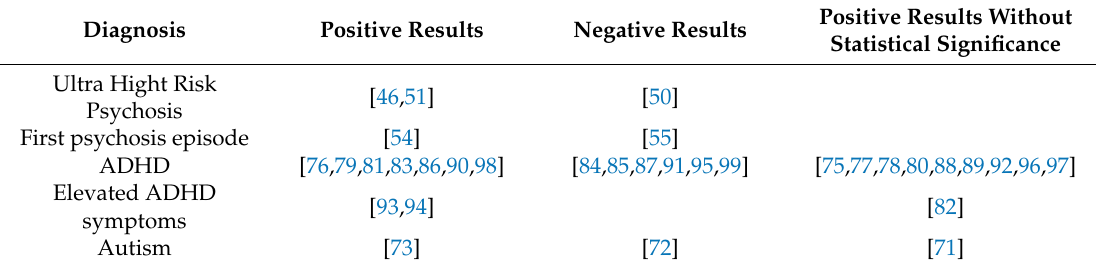
Table 2. Effects of ω -3 PUFAs supplementation in psychosis, ADHD, ASD: